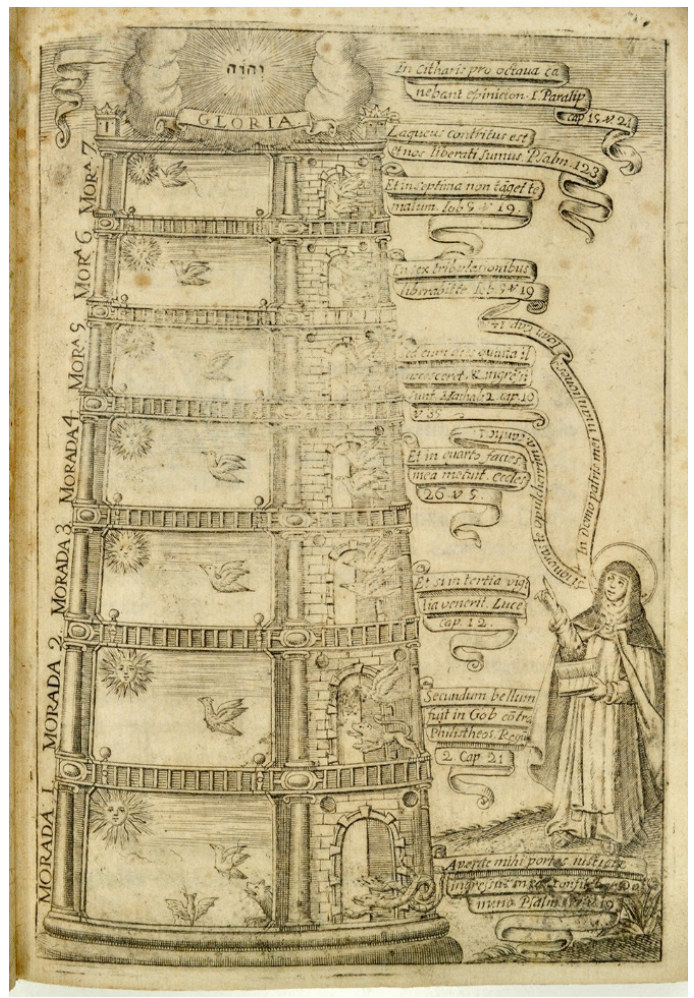
Figure 14. Unidentified artist, The seven dwellings of Saint Teresa , 1677, Antonio González de Reyes, Representaciones de la verdad vestida, misticas, morales, y alegoricas sobre las Siete Moradas de Santa Teresa de Iesús.